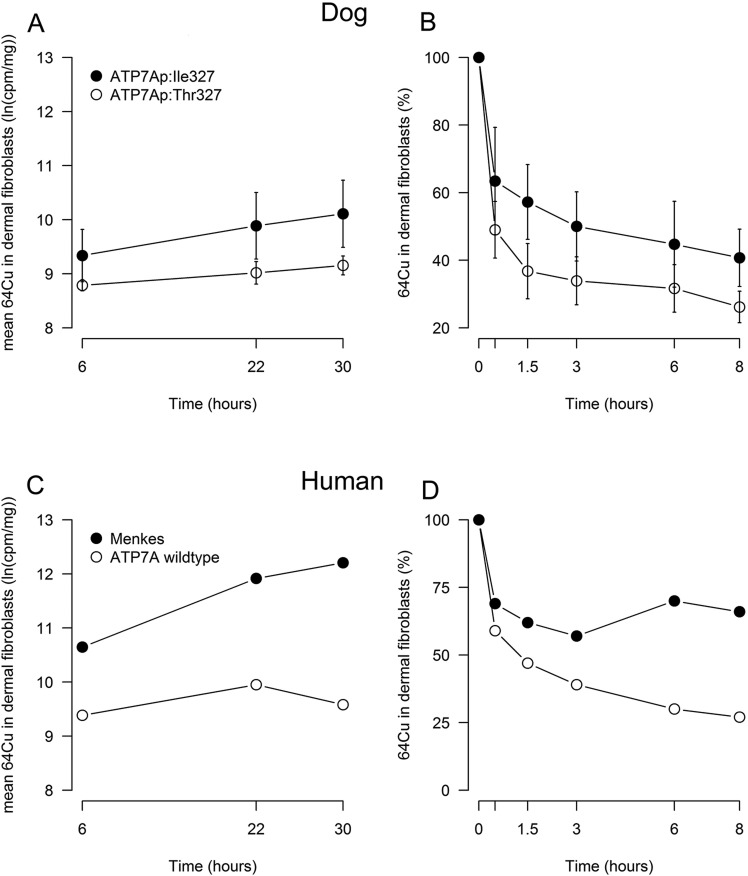
Copper accumulation and retention in canine dermal fibroblasts. (A) Copper influx in canine fibroblasts. Dermal fibroblasts derived from ATP7A:p.Ile327 (ATP7AT327I) dogs showed significantly more uptake of 64Cu than dermal fibroblasts derived from dogs with ATP7A:p.Thr327 (ATP7AWT). The overall difference in copper accumulation was 86% (95% confidence interval 25-176%, P=6.1×10−3). The overall increase in 64Cu was compared to time point 6 h. After 22 h, the estimated increase in copper was 45% (95% confidence interval 27-64%, P<1.0×10−4), and after 30 h this was 72% (95% confidence interval 45-104%, P<1.0×10−4). Dots represent mean values, and standard deviation is represented by the error bars. (B) Copper efflux in canine fibroblasts. Dermal fibroblasts from ATP7AT327I dogs showed significantly more retention of copper than dermal fibroblasts derived from dogs with ATP7AWT. The overall average export rate in ATP7AT327I was significantly lower than in ATP7AWT (P=0.011). Dots represent mean percentages, and standard deviation is represented by the error bars. (C) Copper influx in human fibroblasts. Dermal fibroblasts from a human with Menkes disease showed considerably more uptake of copper than dermal fibroblasts derived from a human with ATP7A wild type. (D) Copper efflux in human fibroblasts. Dermal fibroblasts from a human with Menkes disease showed considerably more retention of copper than dermal fibroblasts derived from a person with ATP7A wild type.